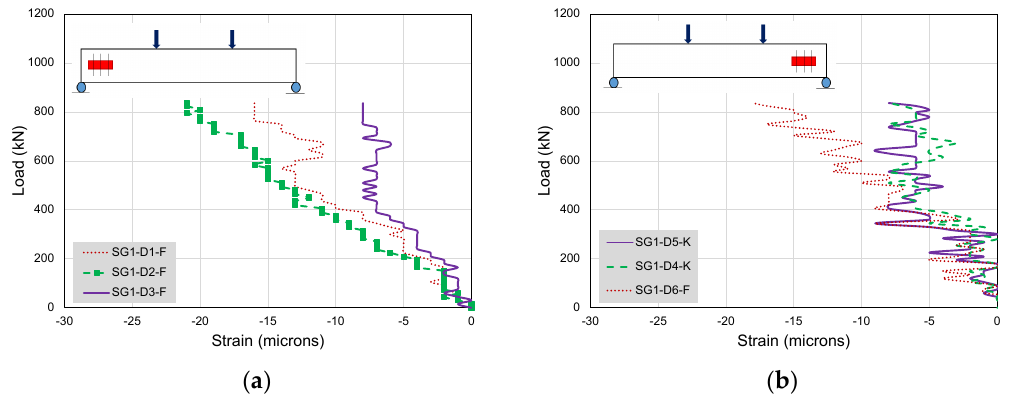
Figure 30. Load versus strain responses in load setup SP-3-L01 ( a ) D1–D3, and ( b ) D4–D6.